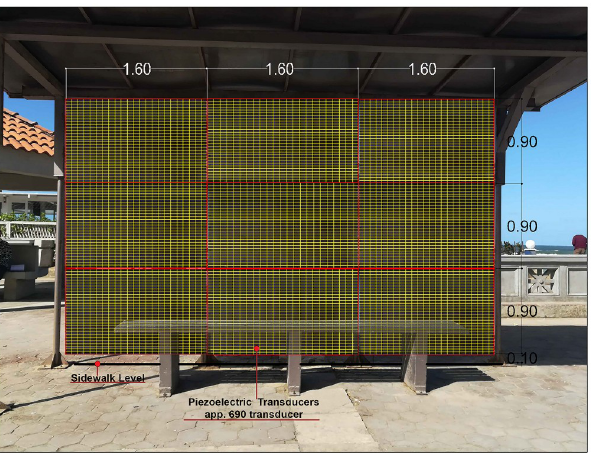
Fig 14. The second proposed area to place the piezoelectric transducers at the bus stop of Cleopatra Station as an example. The area is about 13 m2 and it takes about 6210 QB220-503YB transducers to cover this selected